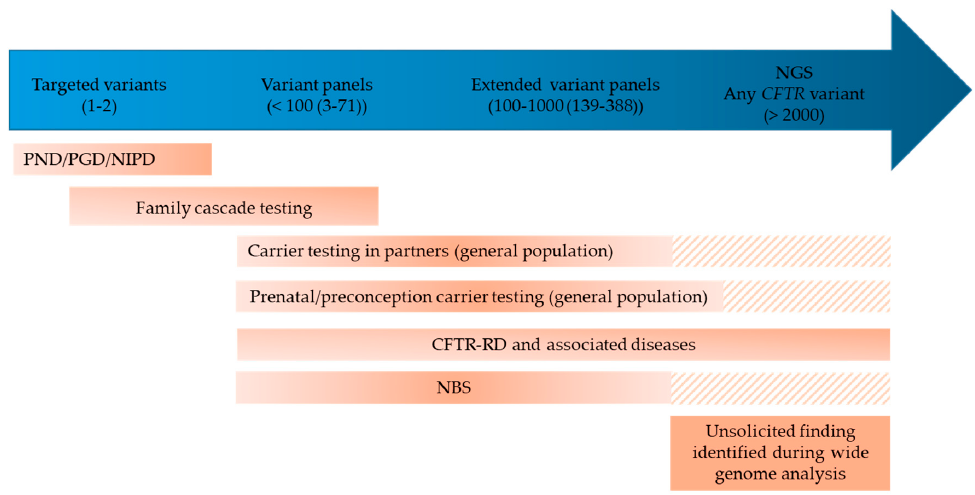
Figure 4. Genetic counseling situations (in orange), with potential identification of CF carriers, according to variable practices of molecular analysis (in blue). The number of variants tested is indicated in brackets. CFTR-RD: CFTR-related disorder; NBS: newborn screening; NIPD: non-invasive prenatal diagnosis; PND: prenatal diagnosis; PGD: preimplantation genetic diagnosis. Hatched lines: expected practice in the near future.